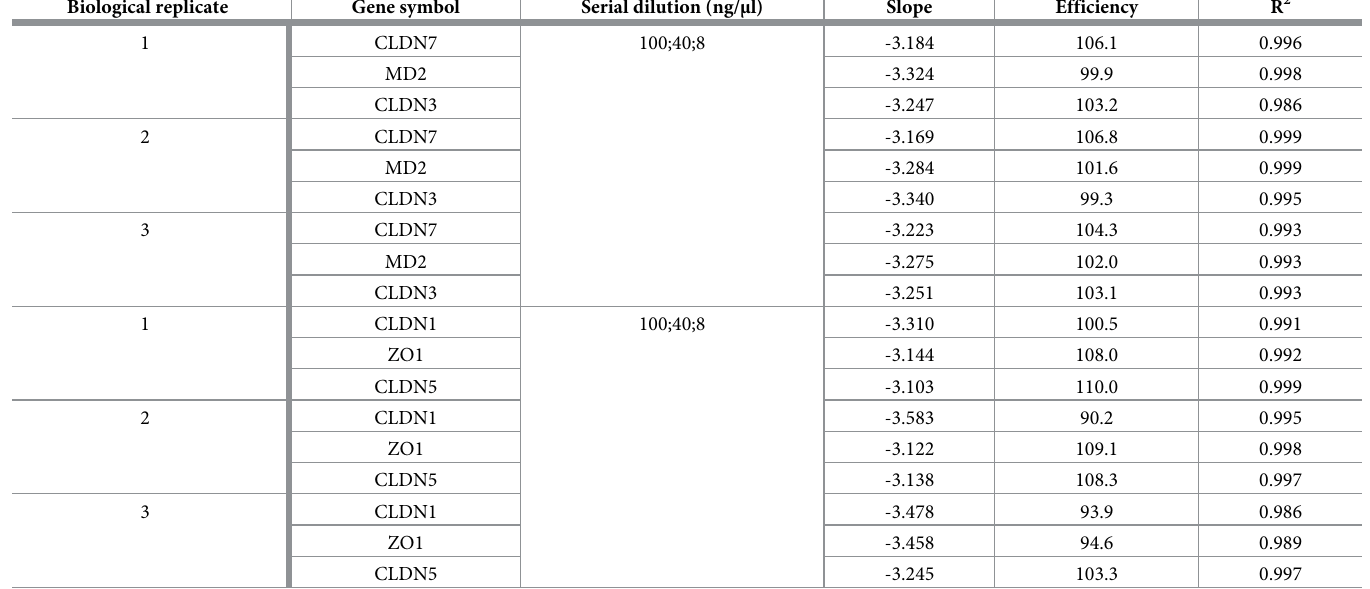
the target genes’ RNA in the sample and S and S´ are the average slopes of the regressions of the standard plots for the 3 test mRNA and the target genes’ RNA, respectively [35]. Further- more, selecting those particular TJs was decided according to the TJ proteins that have been previously expressed in the intestine (also in mammals) in many studies, as well as the possibil- ity to standardize a well-functioning probe based RT-qPCR for the mentioned TJs. Table 5. Multiplex standardization for caecum samples.